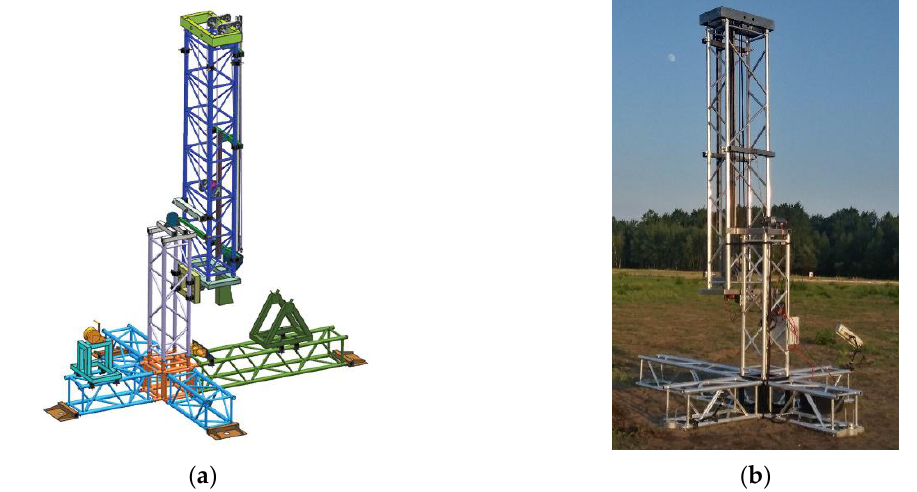
Figure 20. ( a ) The 3D CAD model of the launcher; ( b ) the launcher fully deployed before flight